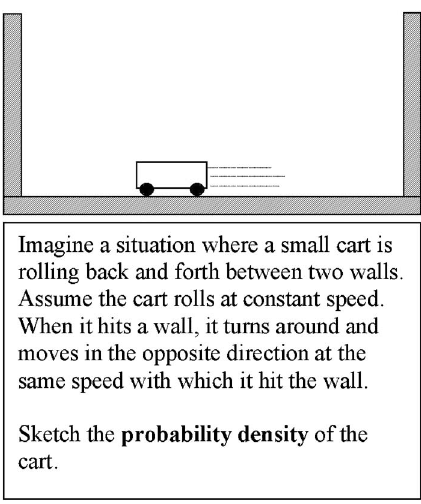
FIG. 7. “Free cart” probability density question. Students an- swered this (cid:1) or a very similar (cid:2) question on a pre-test, post-test im- mediately after instruction, and